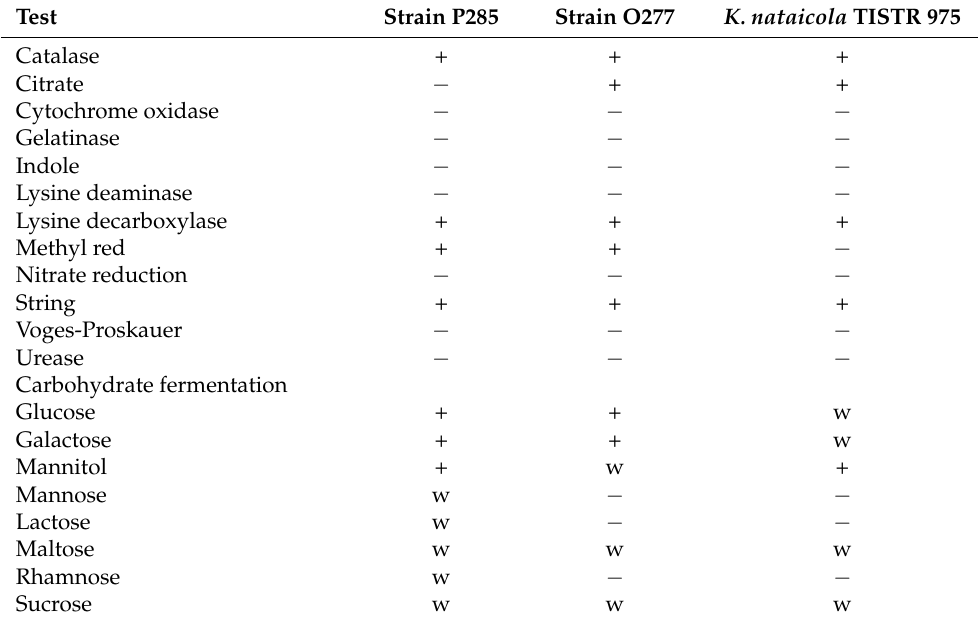
Table 2. Biochemical characteristics of isolated bacterial strains P285 and O277, and K. nataicola TISTR 975. Test Strain P285 Catalase